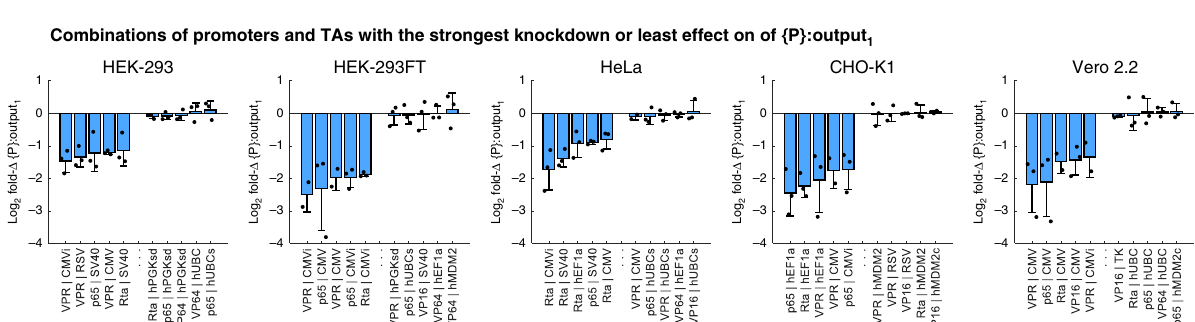
Combinations of promoters and TAs with the strongest knockdown or least effect on of {P}:output 1